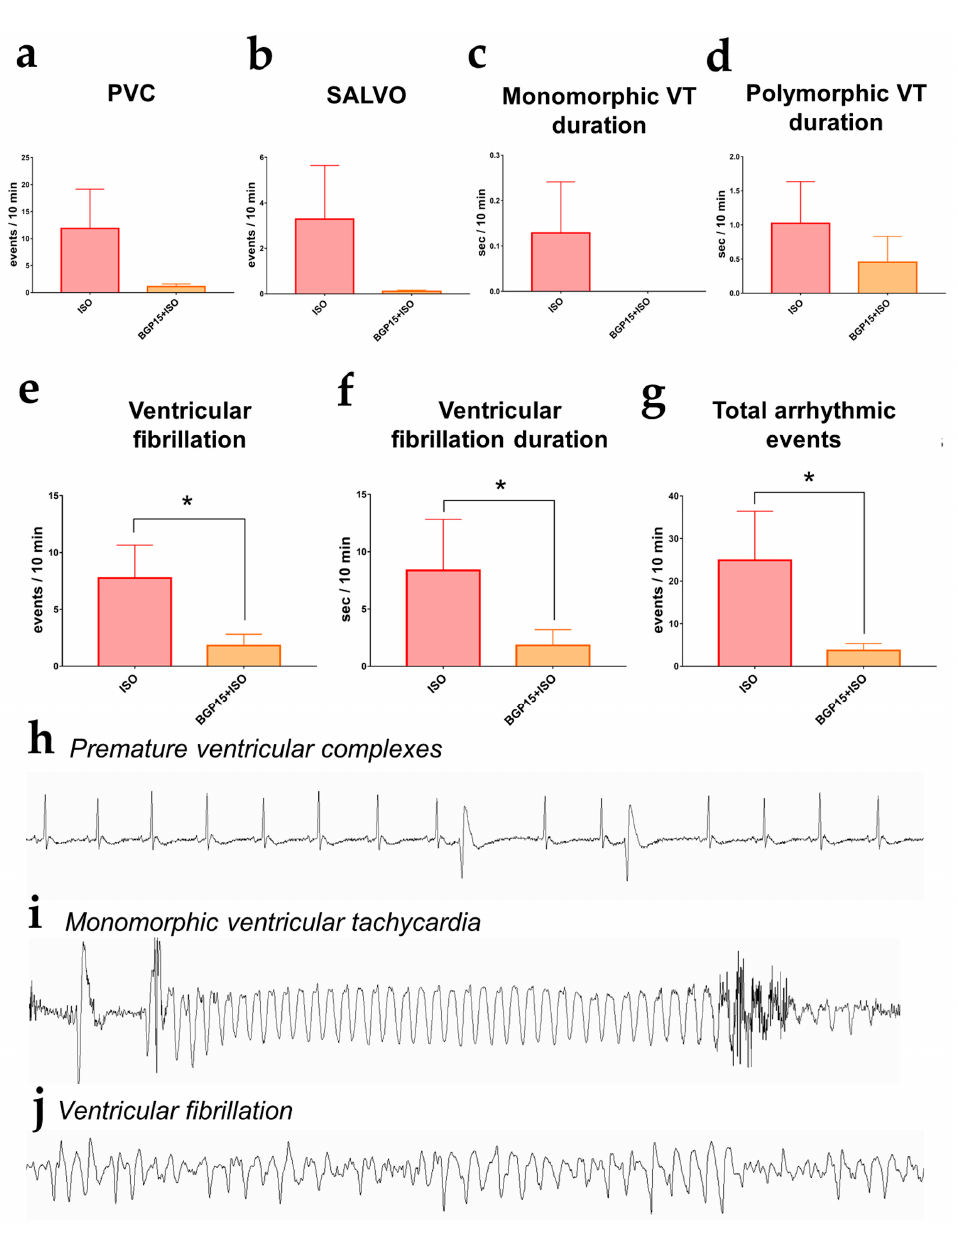
Figure 4. Arrhythmic events (interpolated to a 10 min period) recorded on the last day of Protocol II. ( a ) Number of premature ventricular complexes (PVCs). ( b ) The incidence of salvos. ( c ) Duration of monomorphic ventricular tachycardia. ( d ) Duration of polymorphic ventricular tachycardia. ( e ) The number of ventricular fibrillation events significantly decreased in the BGP-15-treated rats. ( f ) The duration of ventricular fibrillation was shorter in the BGP-15+ISO group. ( g ) The total number of arrhythmic events was decreased in the BGP-15-treated animals. Data distribution was assessed by the Shapiro–Wilk normality test. Groups were compared by the Mann–Whitney test; *: p < 0.05. ( h ) Telemetric lead II ECG recording of ventricular premature complexes. ( i ) ECG recording of a monomorphic ventricular tachycardia ( j ) ECG trace of a ventricular fibrillation episode (all representative recordings were obtained from the experiments).